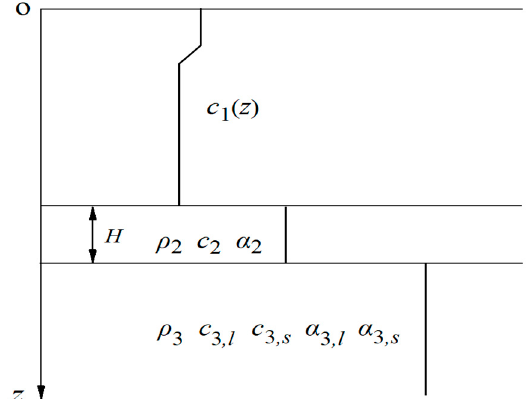
Figure 8. Dual-layer bottom model consisting of a fluid sediment layer and an underlying half-space substrate. c 1 ( z ): sound speed in water layer; H : thickness of sediment layer; ρ 2 , c 2, and α 2 : mass density, sound speed, and sound absorption coefficient of sediment layer, respectively; ρ 3 , c 3, l , c 3, s , α 3, l , and α 3, s : mass density, longitudinal wave speed, shear wave speed, longitudinal wave absorption, and shear wave absorption of elastic substrate, respectively.